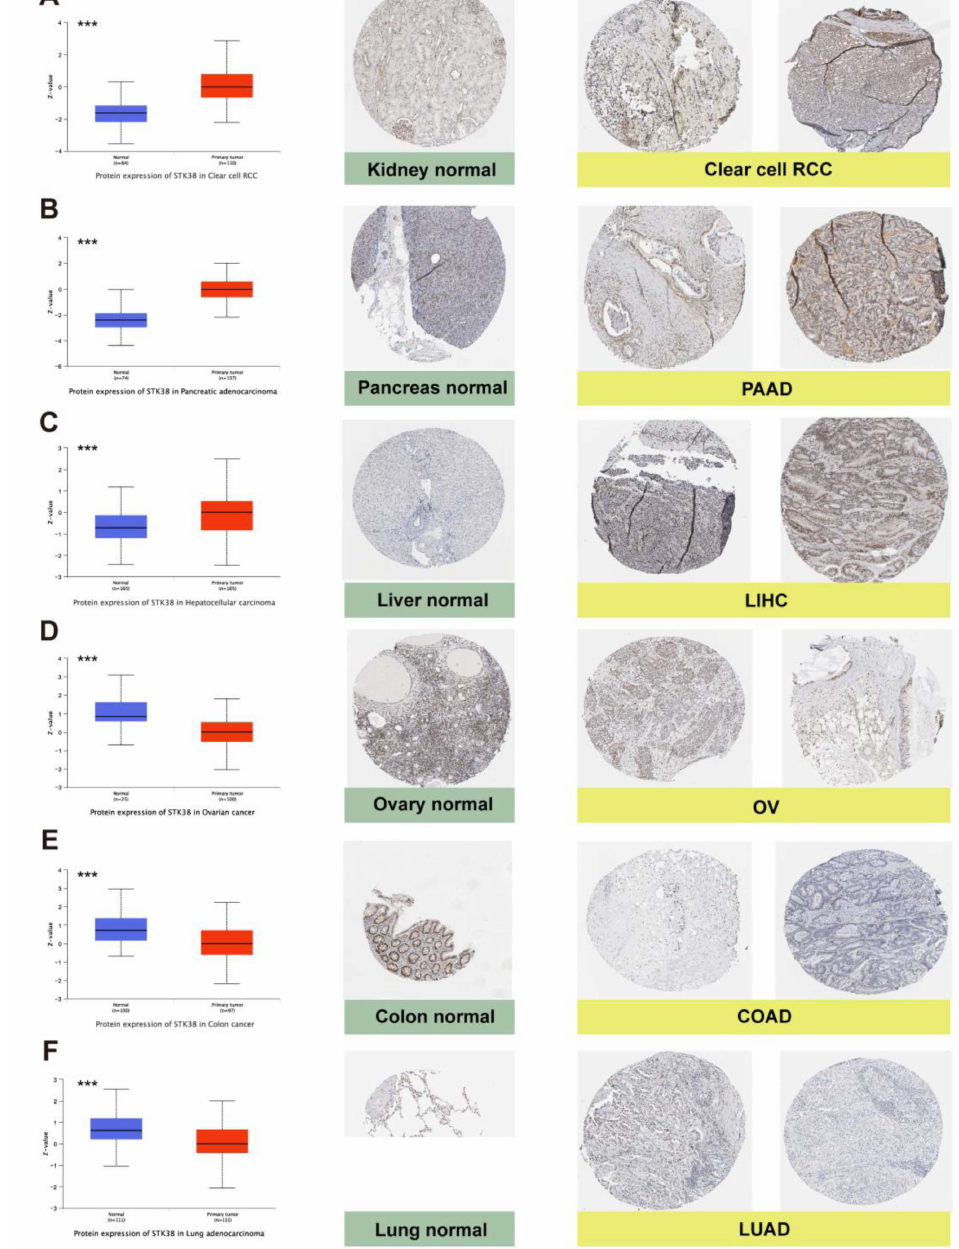
Figure 2. Protein expression levels of STK38 between normal tissues and tumor tissues (left), and representative immunohistochemical staining (IHC) in normal (middle) tissue and tumor (right) tissue samples in the HPA database. STK38 protein expression was significantly higher in clear cell RCC, PAAD and LIHC, and it was lower in OV, COAD and LUAD ( A ) Kidney. ( B ) Pancreas. ( C ) Liver. ( D ) Ovary. ( E ) Colon. ( F ) Lung. (*** p < 0.001). Protein expression data are originated from CPTAC database. Two immunohistochemistry images for each cancer were from different patients. Antibody CAB004673 was used for IHC. Scale bars: 200 µ